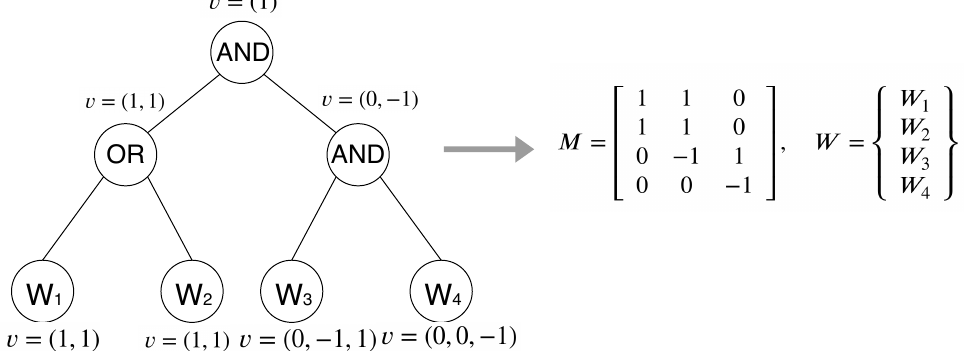
Figure 1. The construction of the LSSS matrix corresponding to the access policy formula of ( W ) and W 3 and W 4 1 or W 2